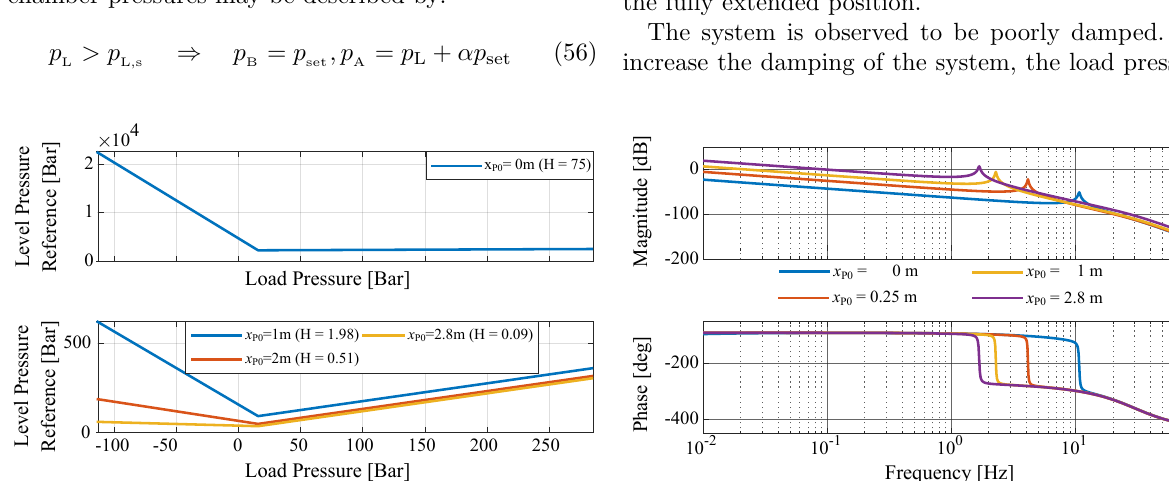
Figure 16: Open loop frequency response at different linearisation points for the transfer function x /q . M eq is p L,ref